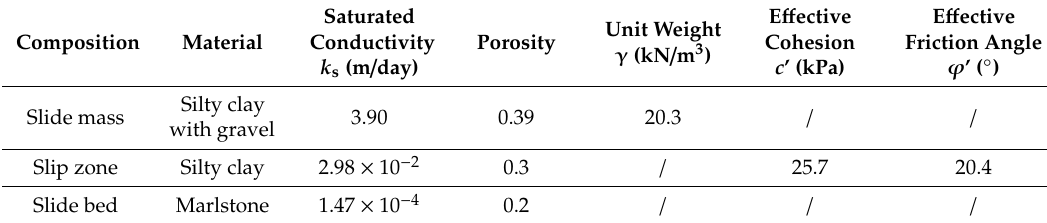
Table 1. Hydrological and mechanical properties of the Shuping landslide.